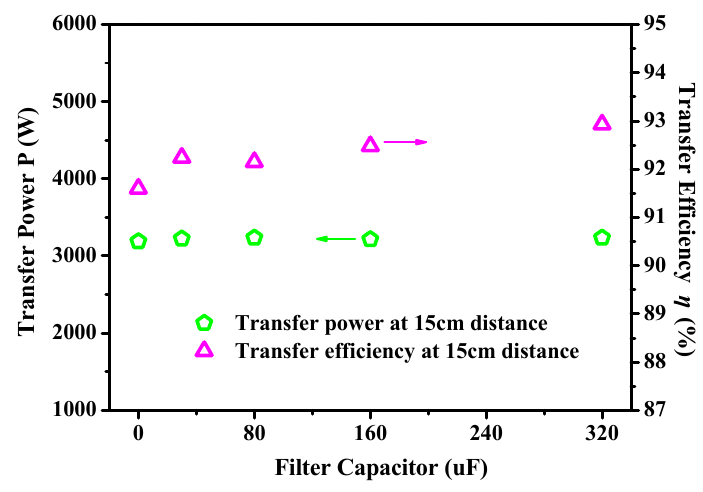
Figure 22. System transfer characteristics with different filter capacitors at 15 cm